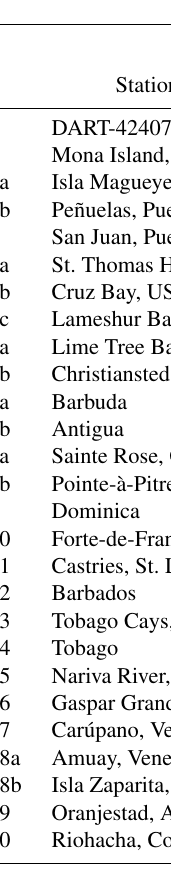
Table A2. Tide gauge stations and tidal statistics: K 1